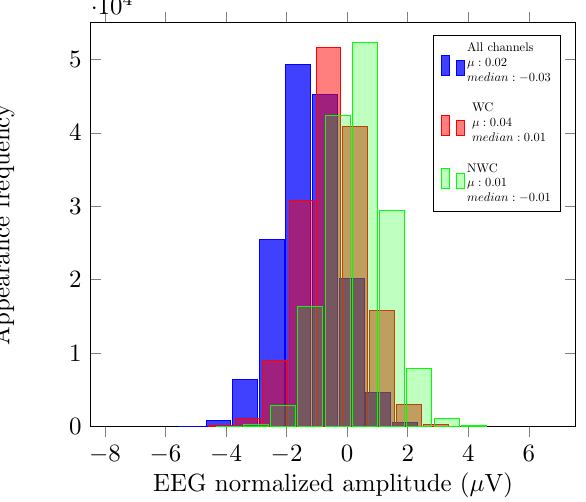
Figure 5. Histograms of User 5 first recording.